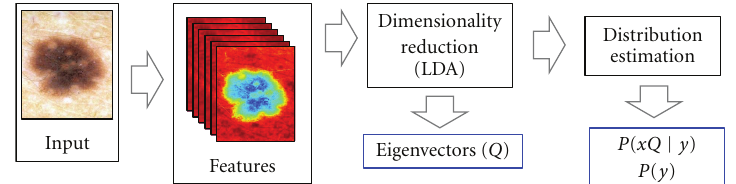
Figure 2: The training phase of our per-pixel (PP) model. Features are first computed, then the dimensionality of the featurespace is reduced using LDA. Posterior probabilities in this subspace are then estimated.